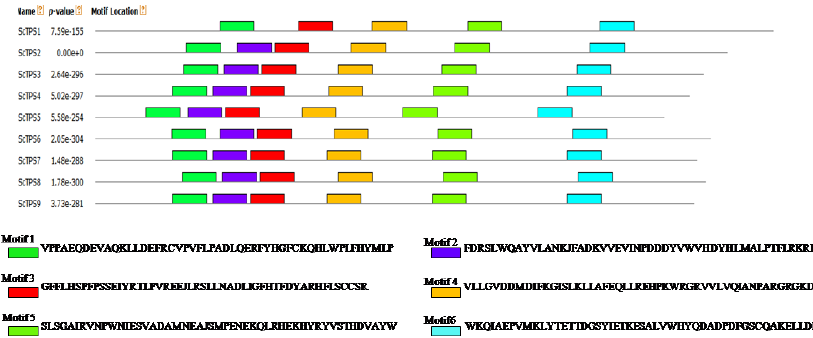
Figure 2. Motif analysis of the trehalose-6-phosphate synthasegene family in sugarcane. The different colored boxes represent different motifs and their positions in each TPS protein sequence.